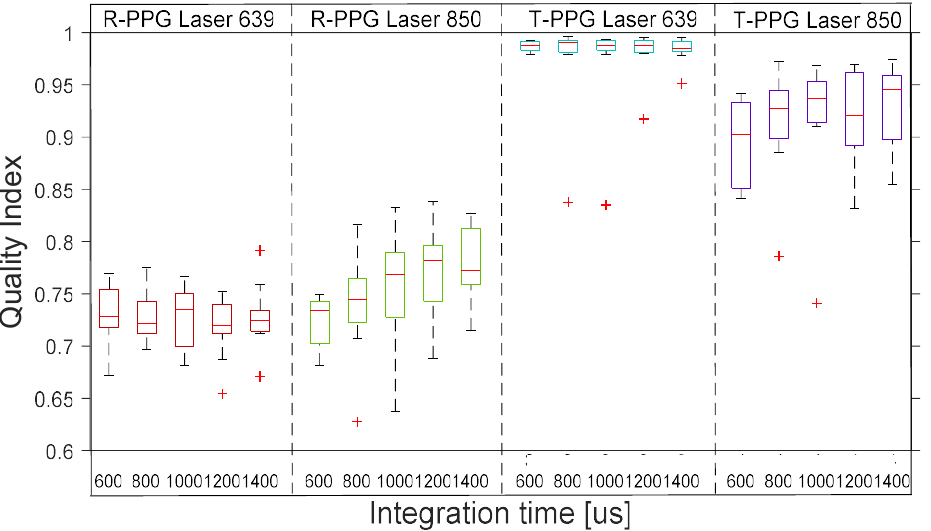
Figure 12. Boxplots of quality index of rPPG signals with 4 different lights at 5 integration times with coherent light in transmission and reflection. The inner box divisions indicate: Q1 (the first quartile) to Q3 (the third quartile). The median is marked by a line across the box. The “whiskers” indicate results from Q1 and Q3 to the most extreme data points. The + symbols represent outliers.